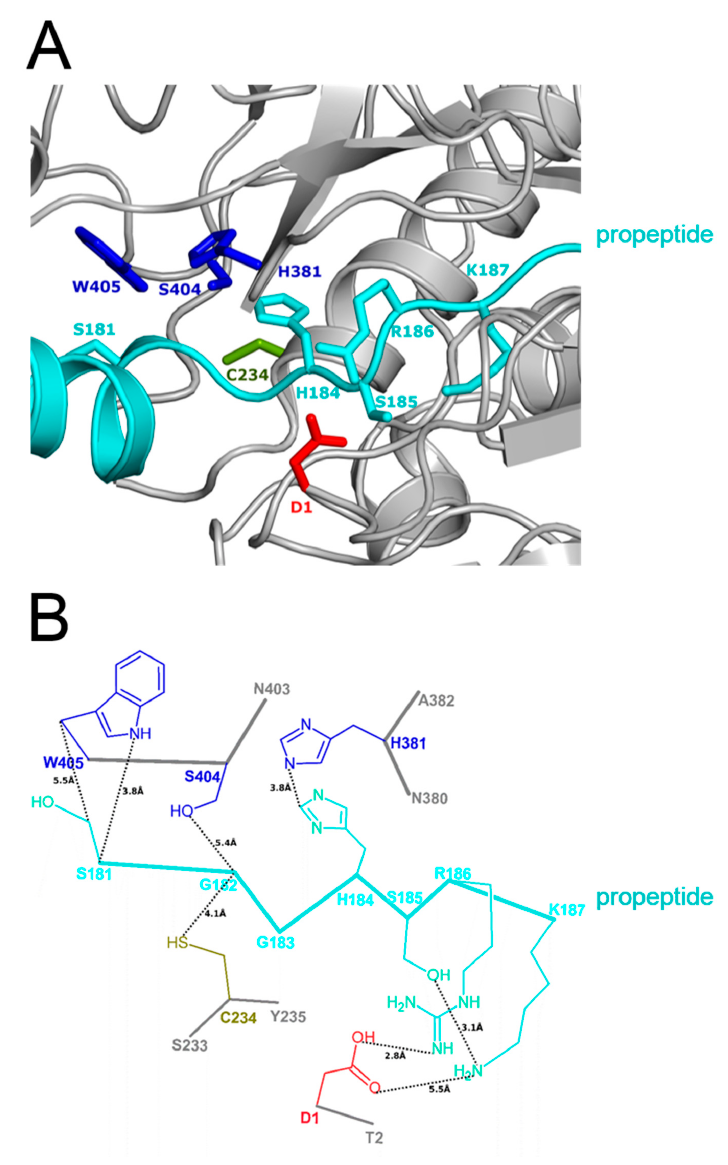
Figure 4. Interactions of propeptide with CatC within the substrate-binding cleft. ( A ) Ribbon presentation of the enzyme (gray) contact with the propeptide (cyan). Residues 181–187 of the propeptide are shown in full. Exclusion domain, propeptide, heavy chain, and light chain residues are shown in red, cyan, green, and blue, respectively. ( B ) The hydrogen bonds between the propeptide and the enzyme residues are shown in a dashed black line with the same color coding as in ( A ). Residues are labeled using their one-letter amino acid code.